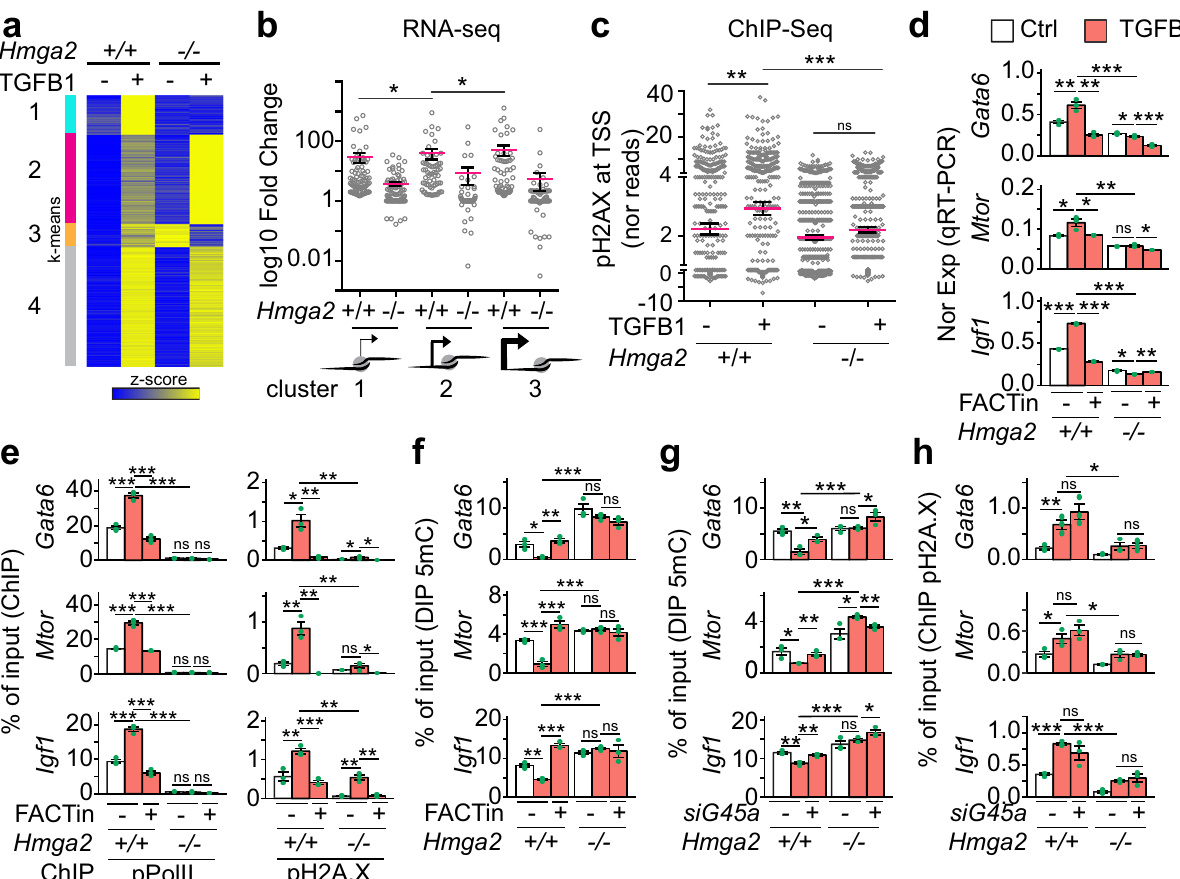
Fig. 8 HMGA2-FACT-ATM-pH2A.X axis mediates TGFB1 induced transcription activation. a Heat map showing RNA-seq-based expression analysis of TGFB1-inducible genes in Hmga2 + / + and Hmga2 − / − MEF non-treated or treated with TGFB1. Data were normalized by Z score transformation and clustered using k -means algorithm. b Dot plot presenting the RNA-seq-based expression analysis of cluster 1 genes from A as log10 fold change between TGFB1-treated and non-treated MEF. Genes were grouped into the position clusters identi fi ed in Fig. 3a. Each dot represents the value of a single gene; n = 95 genes in position cluster 1; n = 64 genes in position cluster 2; n = 78 genes in position cluster 3; red line, average; error bars, s.e.m.; asterisks, P- values after one-tailed Mann – Whitney Test, * P ≤ 0.05. c Dot plot presenting ChIP-seq-based pH2A.X enrichment analysis in the top 15% candidates from Fig. 1c using chromatin from MEF treated as in a. For each gene, normalized reads in the TSS + 0.25 kb region were binned and the maximal value was plotted. Inputs were subtracted from the corresponding samples. Red line, average; n = 640 genes; error bars, s.e.m.; asterisks, P- values after